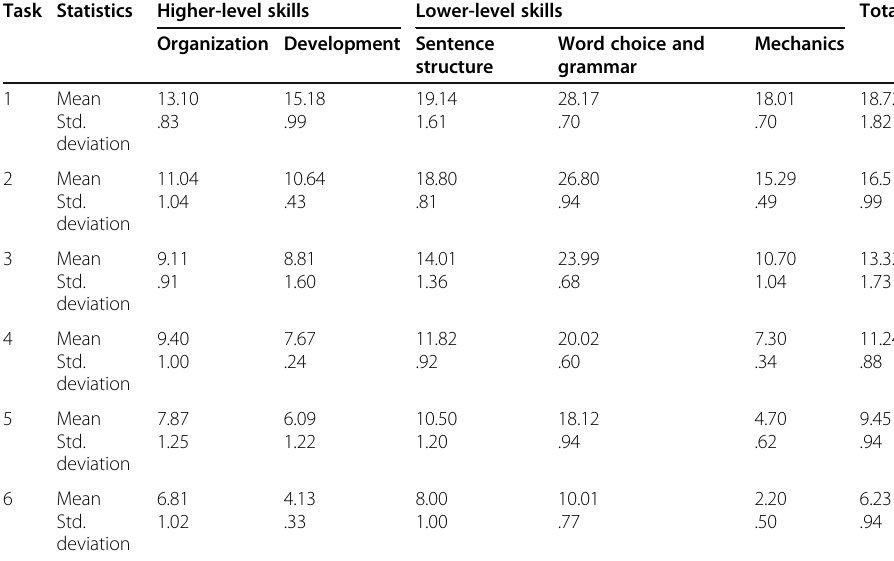
Table 5 Narrative writing tasks: descriptive statistics Task Statistics Higher-level